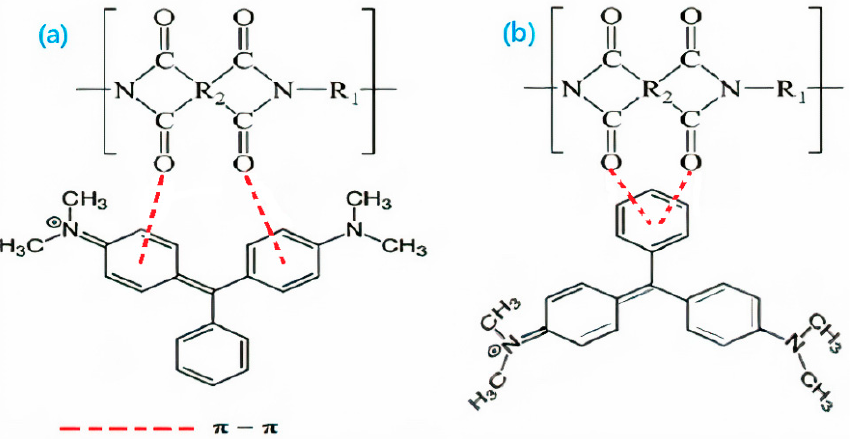
Figure 7. Molecular structures of polyimide nanofiber and MG. Examples of possible different ways of adsorption through π - π interaction by carbon from aromatic amine ( a ) and benzene rings ( b ).